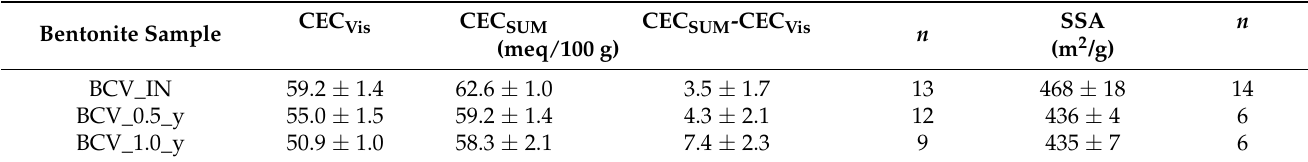
Table 4. Cation exchange capacity and specific surface area data; n corresponds to the number of replicates. Bentonite